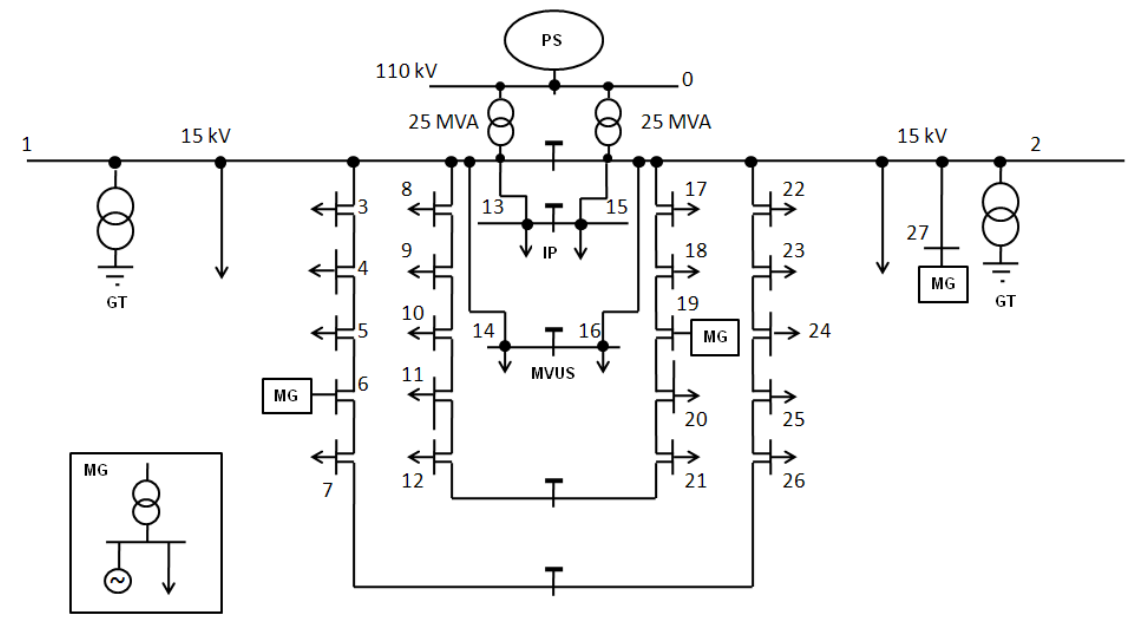
Figure A4. MV distribution network with connected LV microgrids (PS—power system, MG—microgrid, IP—industrial park, MVUS—MV urban distribution substation, GT—grounding trans- former). Table A5. Distributed generation sources and energy consumers connected to the MV distribution network with LV microgrids.